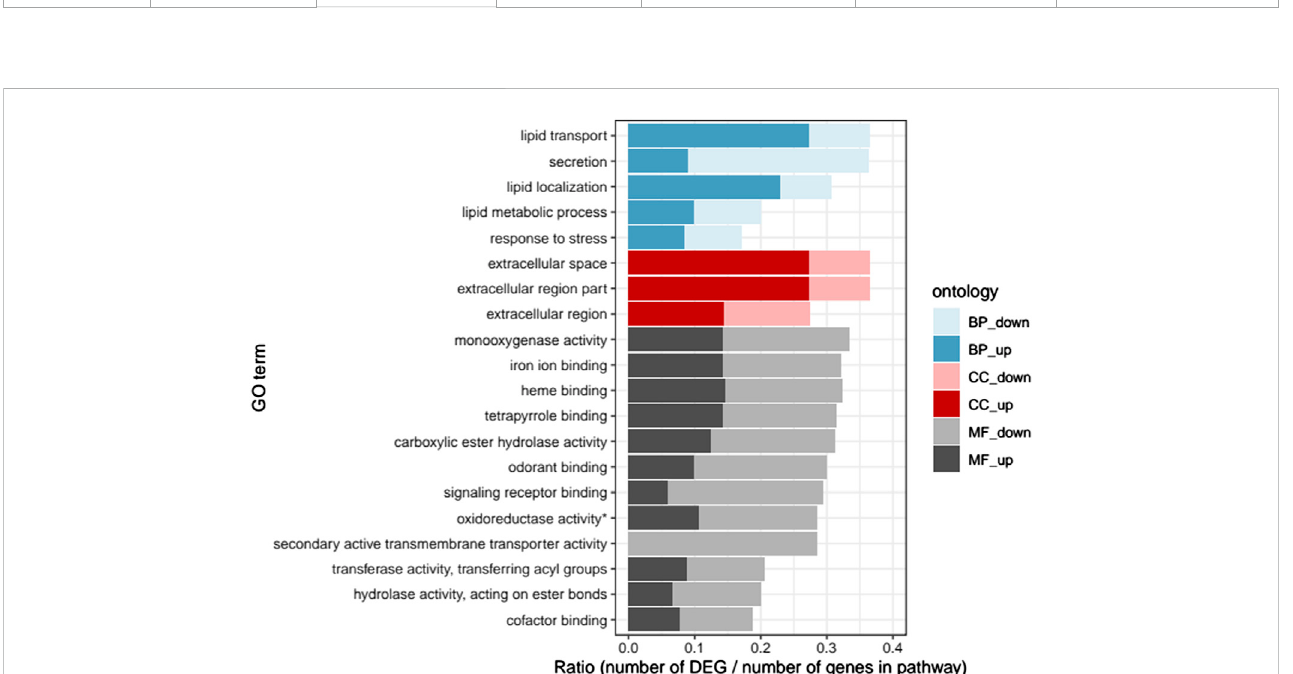
FIGURE 1 Geneontologyenrichmentanalysis:Ratioofthenumberofup-anddownregulateddifferentiallyexpressedgenes(DEGs)overthetotalnumberofgenes in each pathway, for the 20 signi fi cantly enriched GO pathways ( p < .05). “ BP ” , biological process; “ CC ” , cellular component; “ MF ” , molecular function; “ up", upregulated; “ down ” , downregulated (* oxidoreductase activity acting on paired donors, with incorporation or reduction of molecular